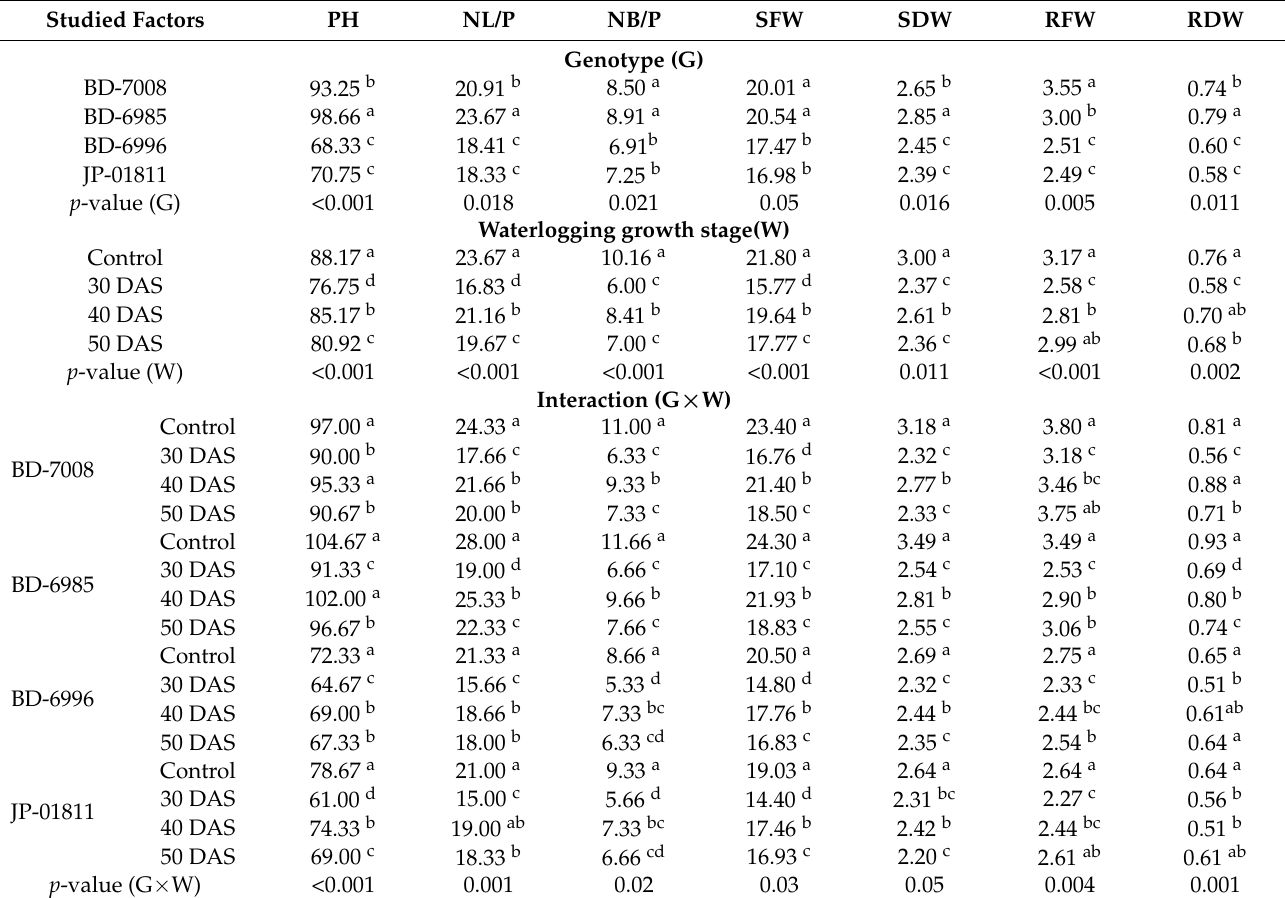
Table 6. Growth parameters of the sesame genotypes as influenced by waterlogging stress at different growth stages. Studied